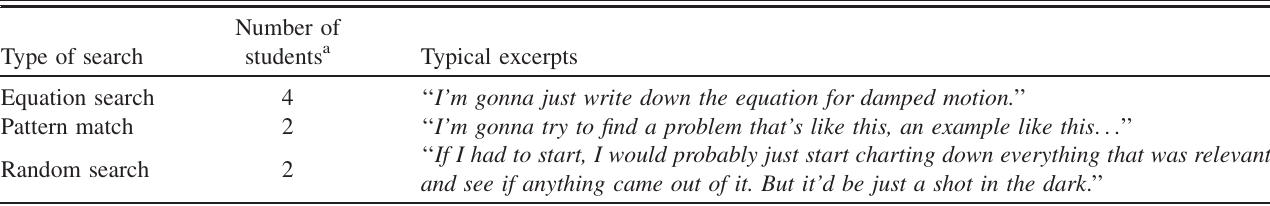
TABLE I. Typical excerpts from the PPG students who approached the problem by equation search, pattern match, or random